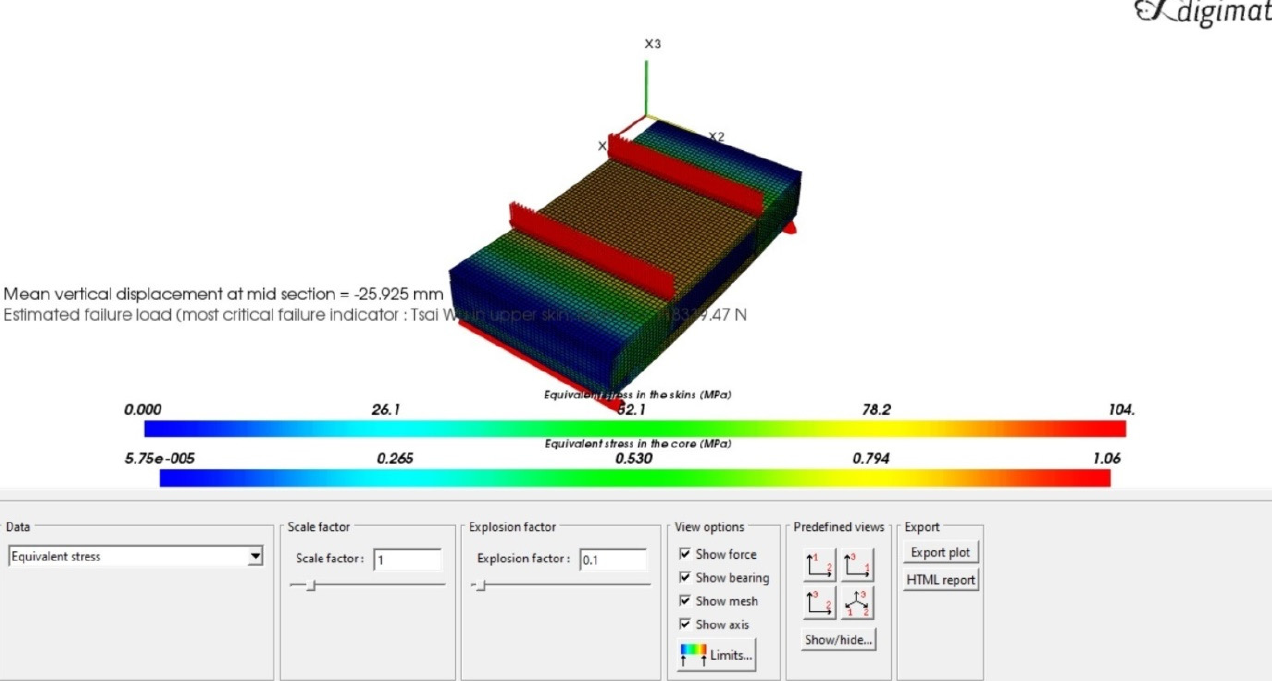
Figure A2. The four-point bending test for the sandwich plate of the helicopter floor numerical model. FRP honeycomb core ( 𝑡 (cid:3030) = 136 mm) and woven glass fiber with epoxy resin face sheets ( 𝑡 (cid:3033) = 1 mm).